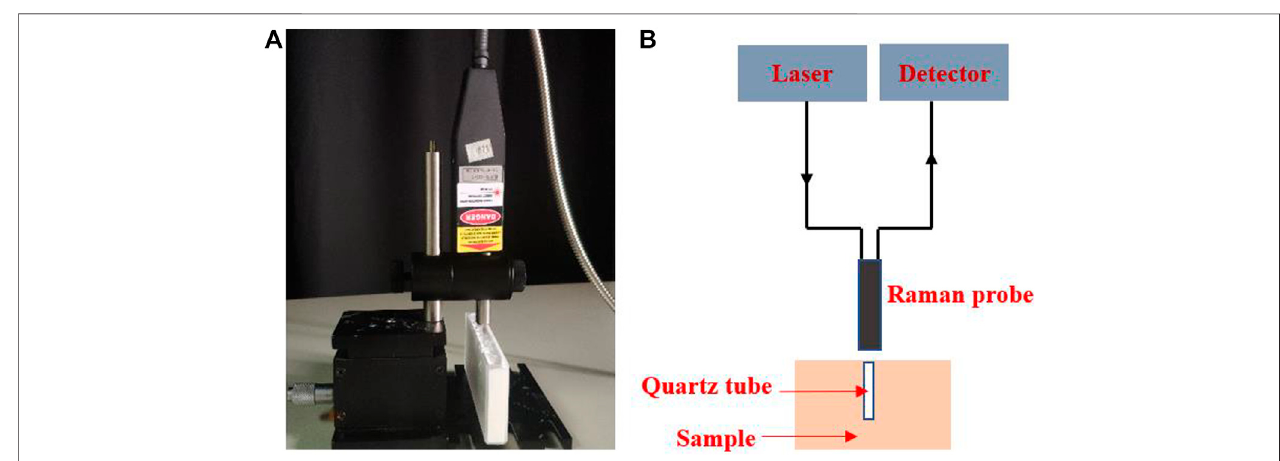
FIGURE 3 | Schematic of the quartz tube enhanced Raman spectroscopy system. (A) Experimental setup; (B) Schematic diagram.